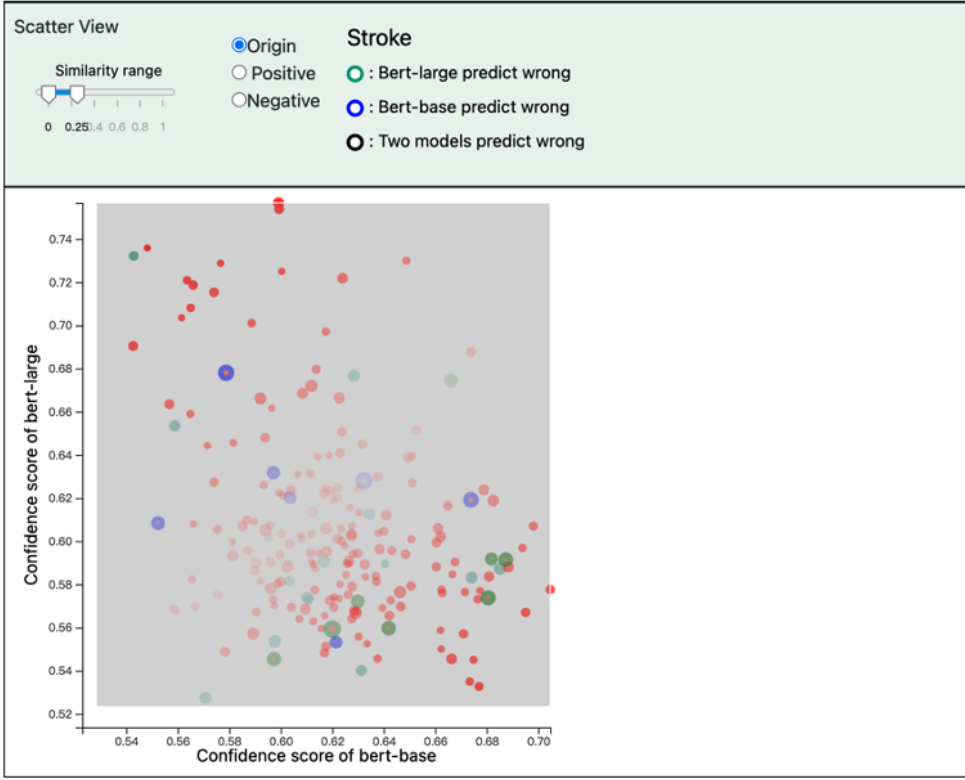
Figure 16. The user filters the instances of lower similarity and selects them